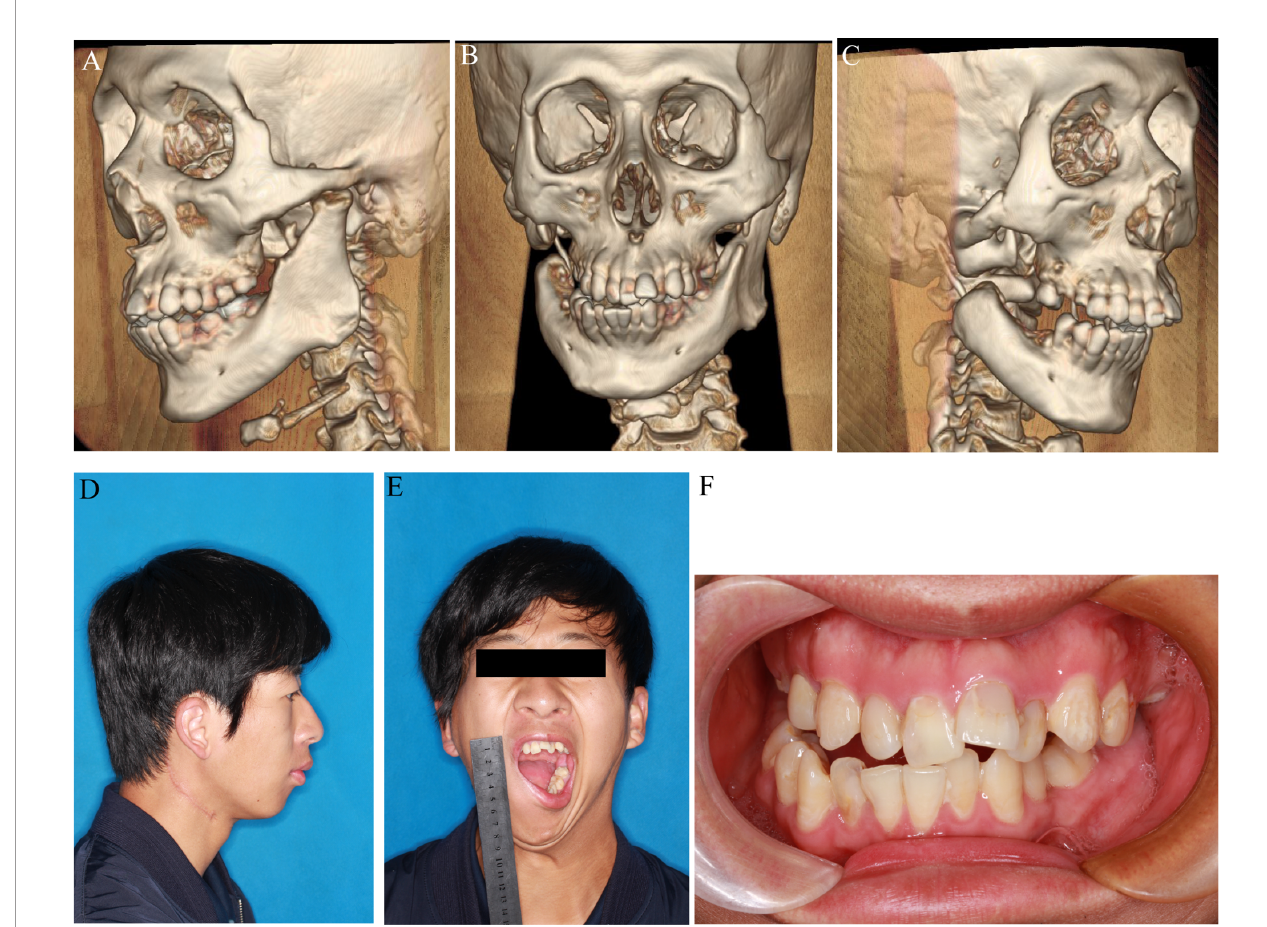
FIGURE 4 | Pre-operative pro fi le. (A – C) 3D reconstruction after surgery. (D, E) Lateral and front view before surgery. (F) Occlusal relationship before